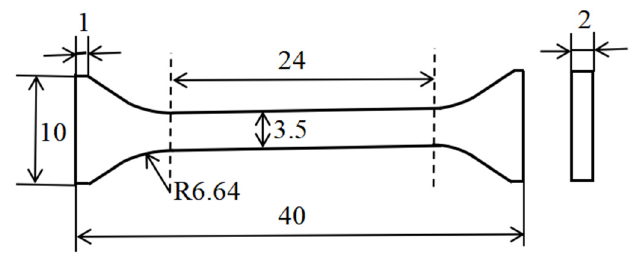
Figure 2. Geometry and dimensions of specimens used for tensile testing.